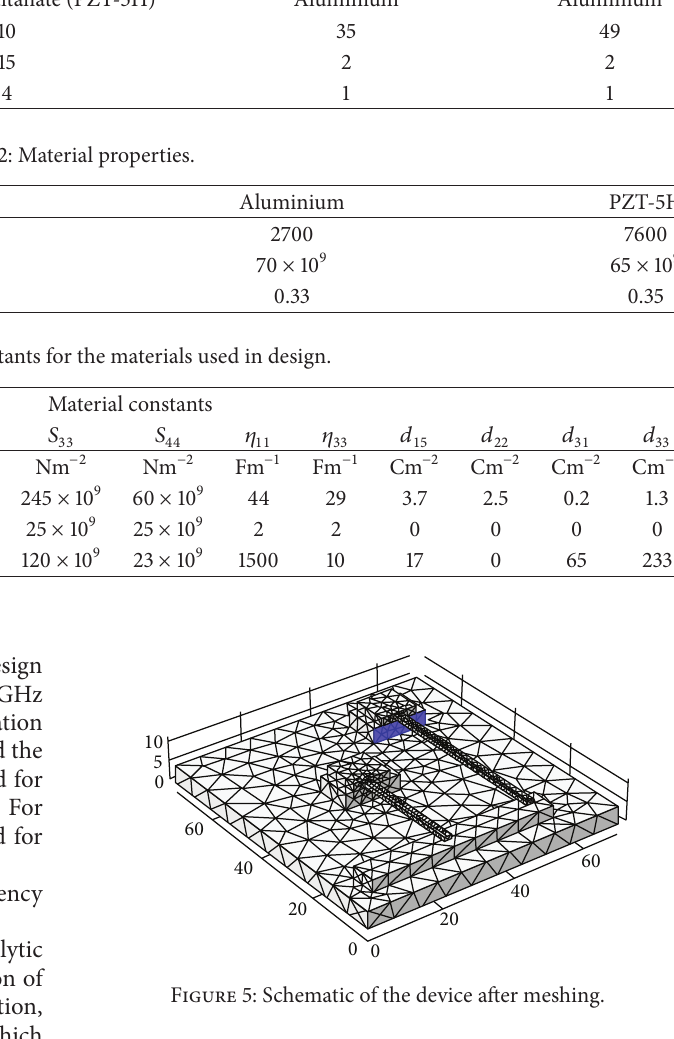
higher values of mean stress at the microlevel are generated in different locations of the